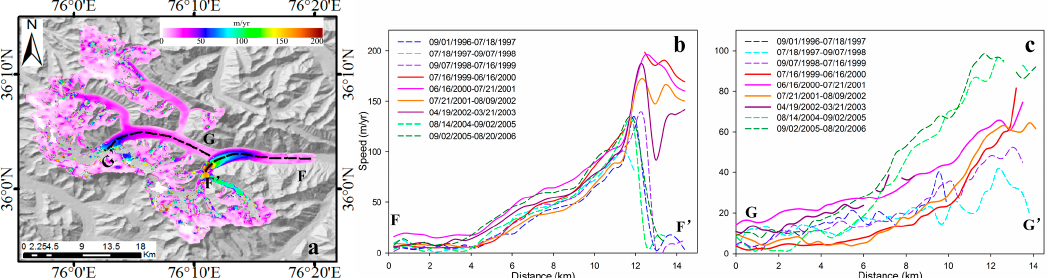
Figure 8. ( a ) Surface velocity over the Skamri Glacier (2000–2001) and FF’ and GG’ are the centerlines of the South Skamri Glacier and Skamri Glacier; ( b ) Annual speed profiles along the centerline (FF’) of the South Skamri Glacier from 1996 to 2006; and ( c ) Annual speed profiles along the centerline (GG’) of the Skamri Glacier from 1996 to 2006.